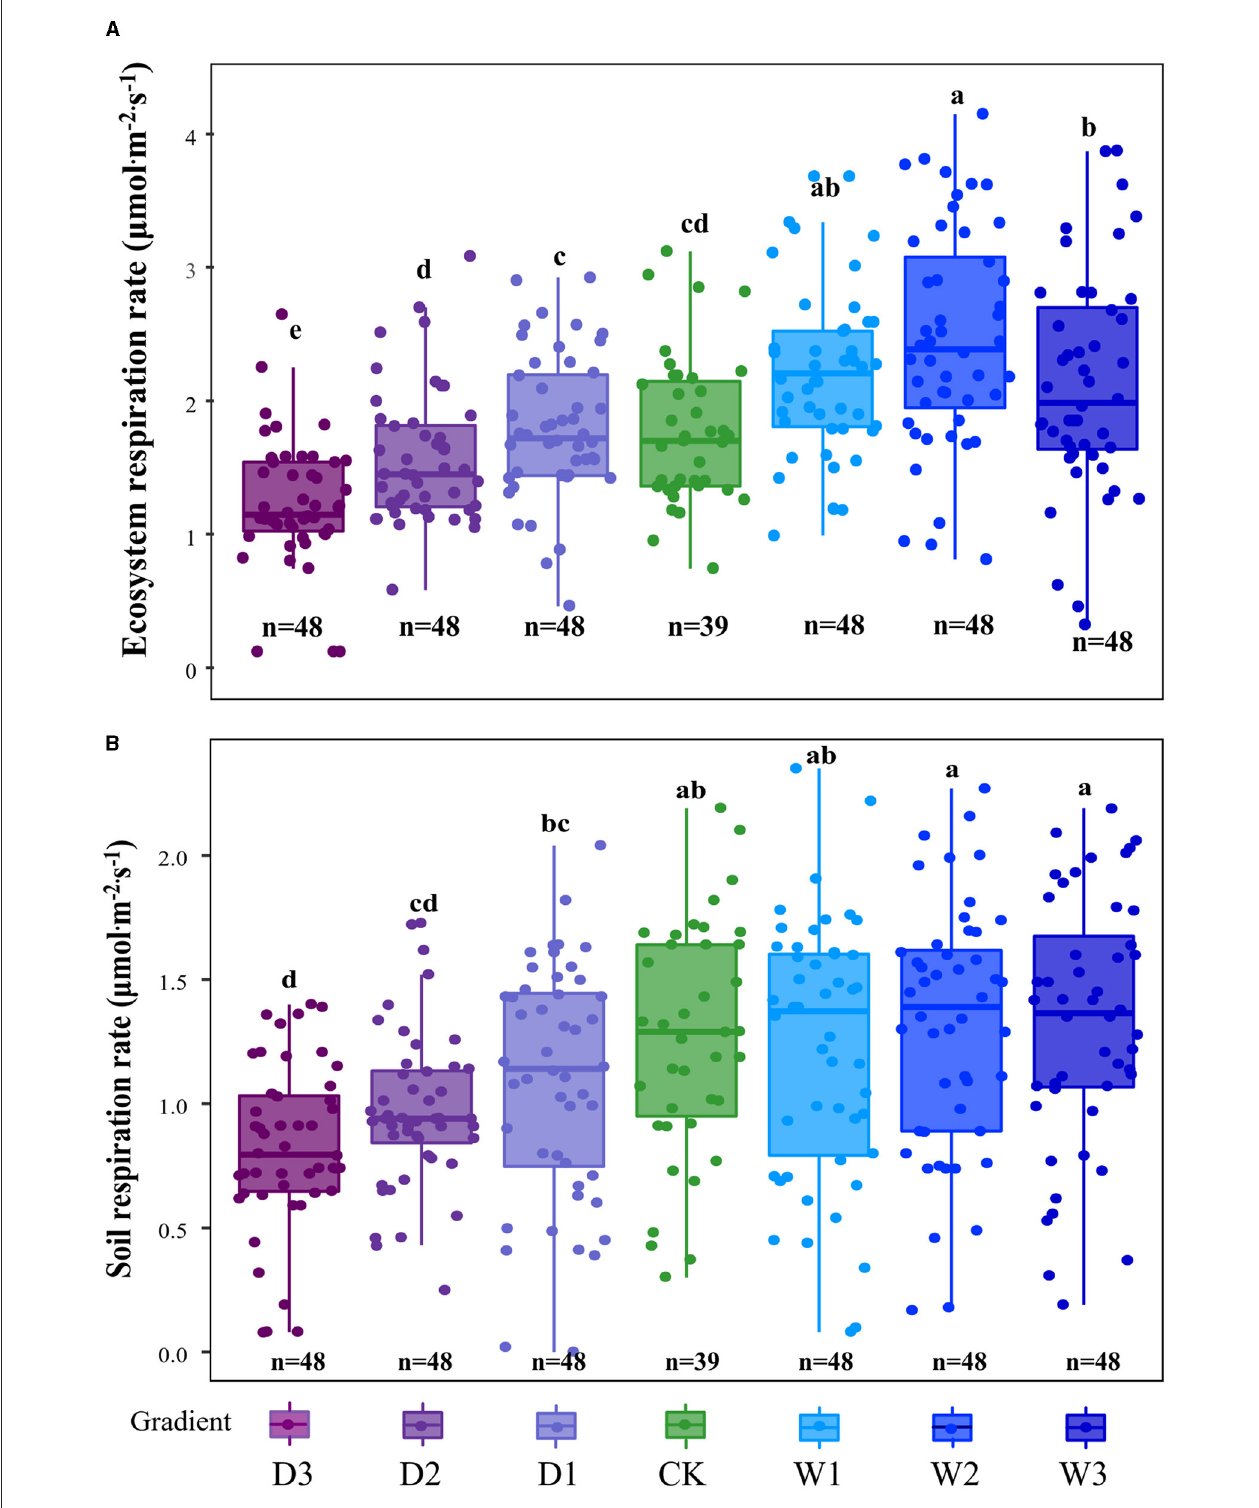
FIGURE 2 | (A) Ecosystem respiration rate and (B) Rs rate under different precipitation treatments; 25% reduction (D1), 50% reduction (D2), 75% reduction (D3), control (CK), 25% increase (W1), 50% increase (W2), and 75% increase (W3). “ n ” denotes the number of measurements. Different letters (a, b, c, d, and e) represent the significant differences at p <